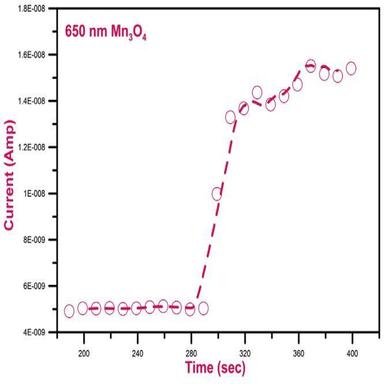
Time response of 650 nm Mn3O4 film to artificial sweat. It can be seen that the response time is around 40 s before the output reaches to a steady-state value.